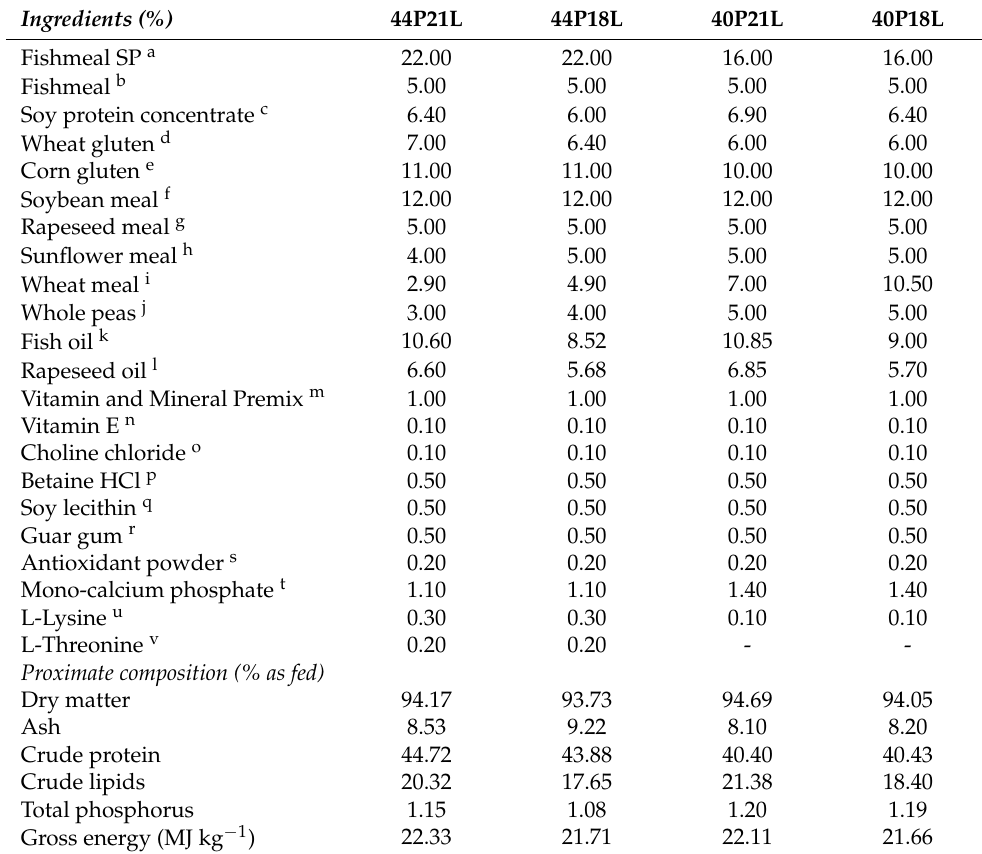
Table 1. Formulation and proximate composition of experimental